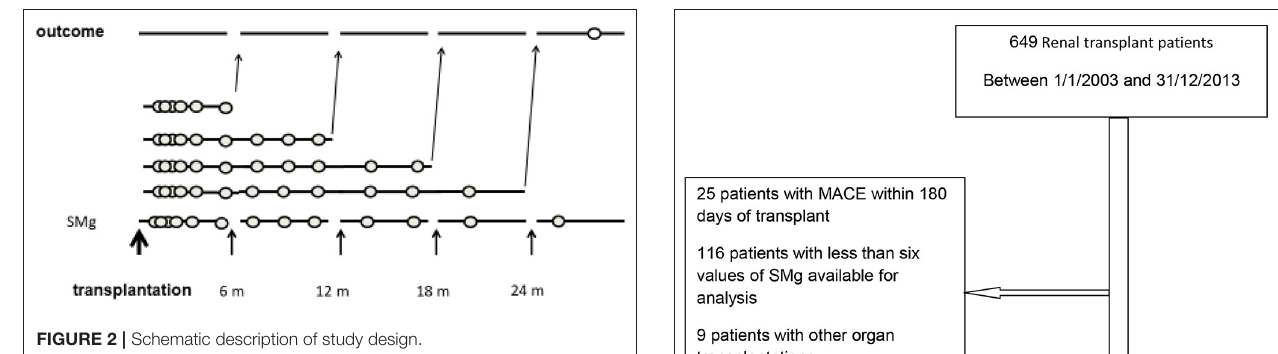
FIGURE 2 | Schematic description of study design.